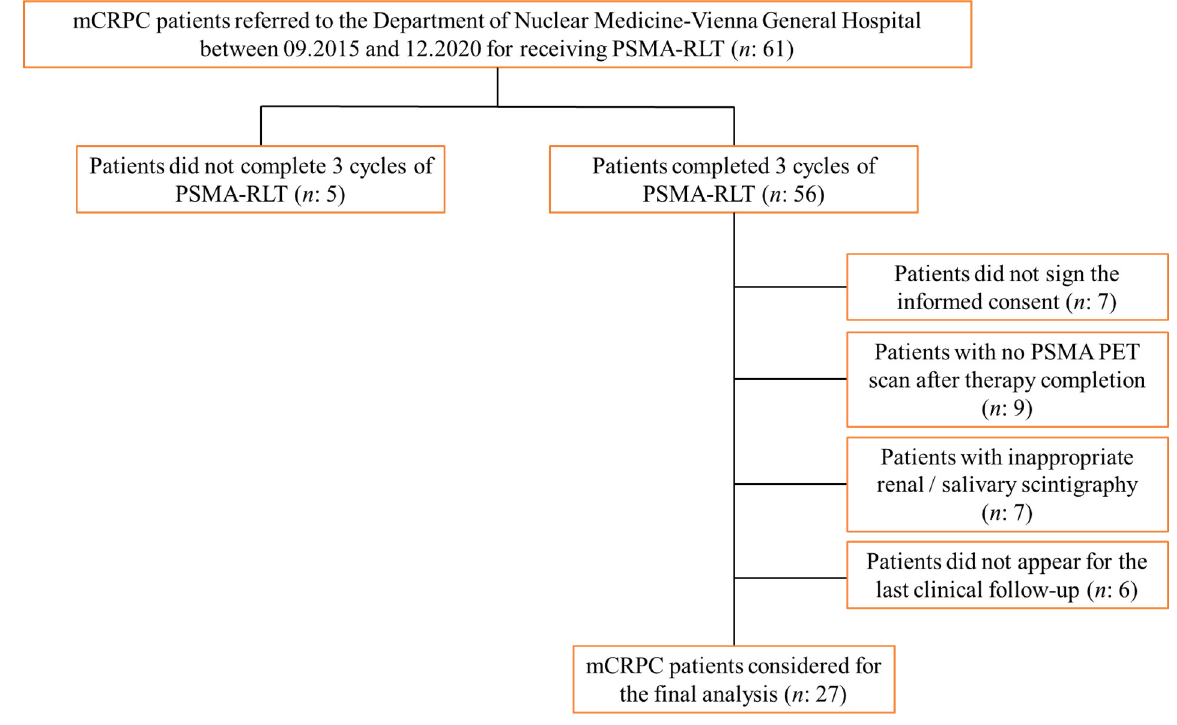
Figure 1. Flowchart for the selected mCRPC patients included in this study.